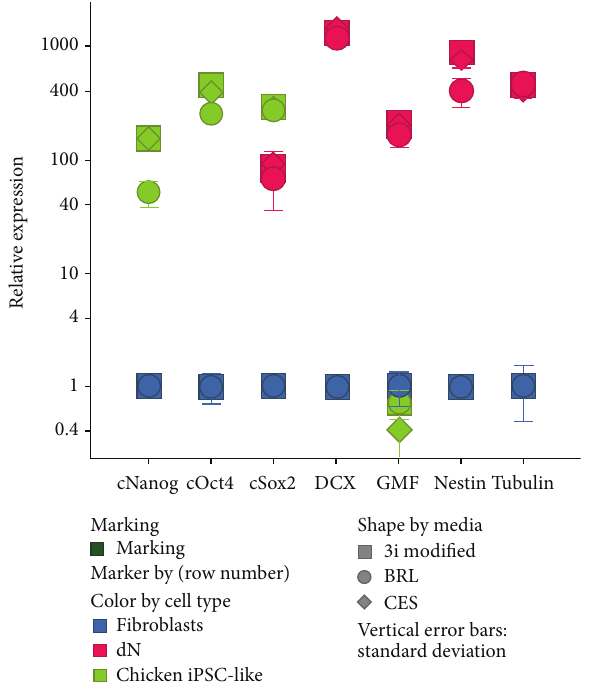
Figure 3: qRT-PCR of chicken iPSC-like cells at the 7th passage and differentiated neurons in comparison to chicken embryonic fibrob- lasts. cNanog, cOct4, and cSox2 are chicken homologs of genes normally expressed in stem cells relative to fibroblast; chicken Sox2, DCX, Nestin, and beta-tubulin III are in neurons and GMFB in glial cells. The differentiated neuronal culture used was from 10 days after induction. Values below 0.4 are not shown in the figure (barely detectable). DCX and tubulin had no (zero) detectable expression in chicken iPSC-like cells cultured in 2i+ modified media. cNanog and cOct4 had no detectable expression in differentiated neurons. Glia maturationfactorhad0.72 ± 0.21relativeexpressionsandNestinhad 0.0047 ± 0.00034 in PRPSCs. The values are from 𝑛 = 3 independent replicates. Error bars, SEM. 𝑃 < 0.05 , relative to fibroblast controls.